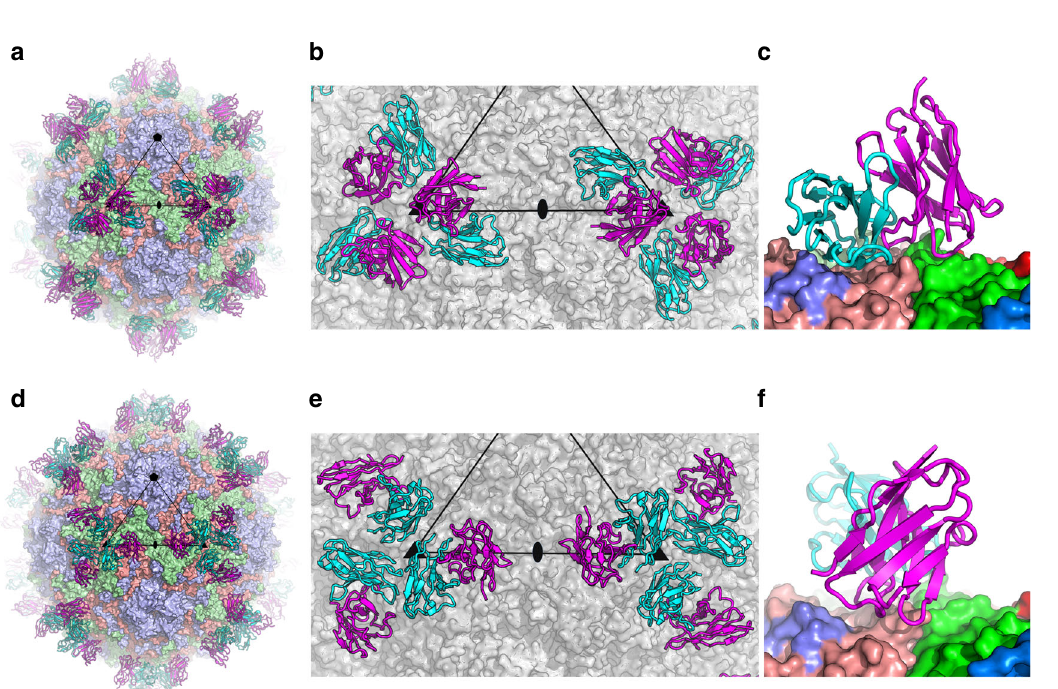
Fig. 4 Overall structures of EV71/38-1-10A and EV71/38-3-11A complexes. a The structure of the EV71/38-1-10A complex viewed along an icosahedral twofold axis. The viral capsid proteins are shown as surface representations coloured in light blue, pale green and salmon for VP1, VP2 and VP3, respectively. For clarity, only the Vh and Vl domains of the Fab are shown as ribbons with Vh in magenta and Vl in cyan. One icosahedral asymmetric unit of the viron is outlined. b Close-up of 38-1-10A Fab binding around two threefolds. The colour scheme is as for a, but the virus is shown in grey. c Side view of b . Only one Fab is shown for clarity. d – f EV71/38-3-11A complex. The drawing, colour scheme and view direction of each panel are the same as that of a – c